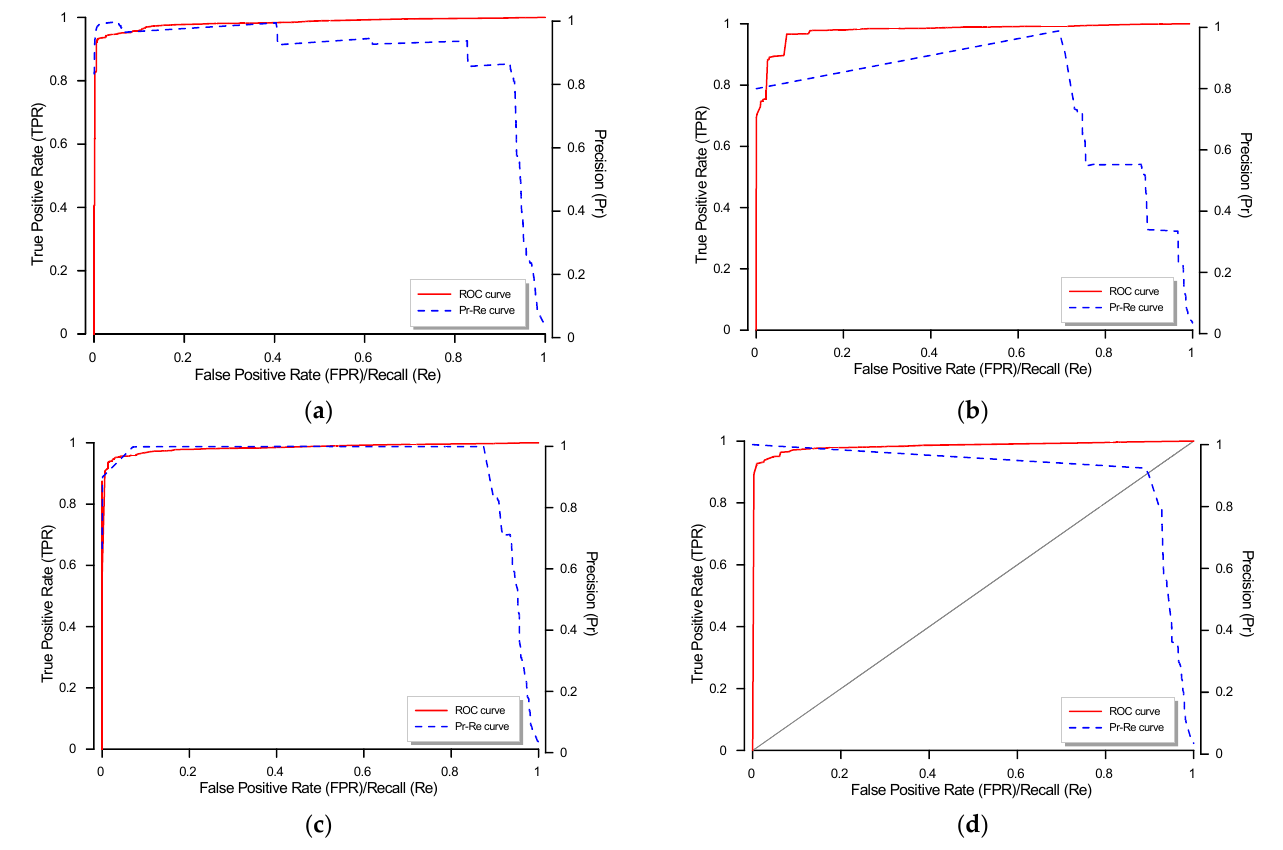
Figure 7. Receiver operating characteristic (ROC) and Precision-Recall (Pr-Re) curves for classification results provided by the proposed methodology for ( a ) 2017, ( b ) 2018, ( c ) 2019, and ( d ) 2020. According to the ROC profiles, the proposed method tends to deliver high True Positive Rates (TPR) and low False Negative Rates. According to the Pr–Re curves, there is a good balance between the Precision and Recall measures. The Area Under Curve (AUC) measurements for both ROC and Pr-Re profiles quantify the high effectiveness of the introduced method.